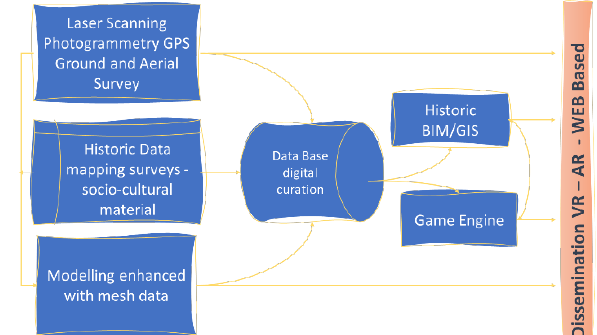
Figure 18. A virtual documentation, analysis and modelling framework for the visualisation and presentation of built